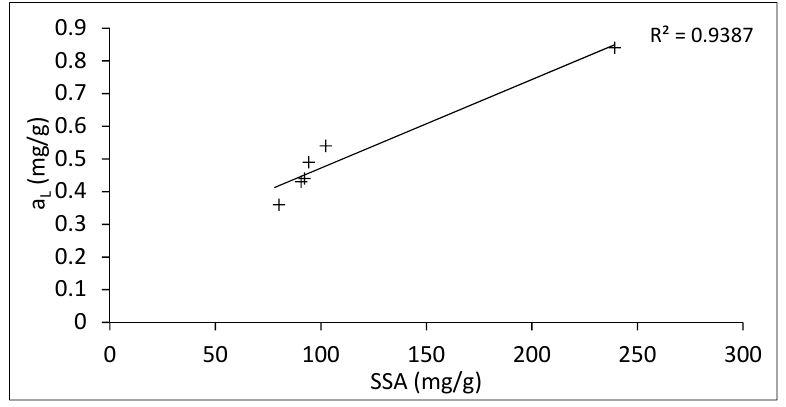
Figure 7. The maximum absorbed amount ( a L ) of ANT as a function of BET SSA of Hal-CNT composites. The solid line represents linear fitting.